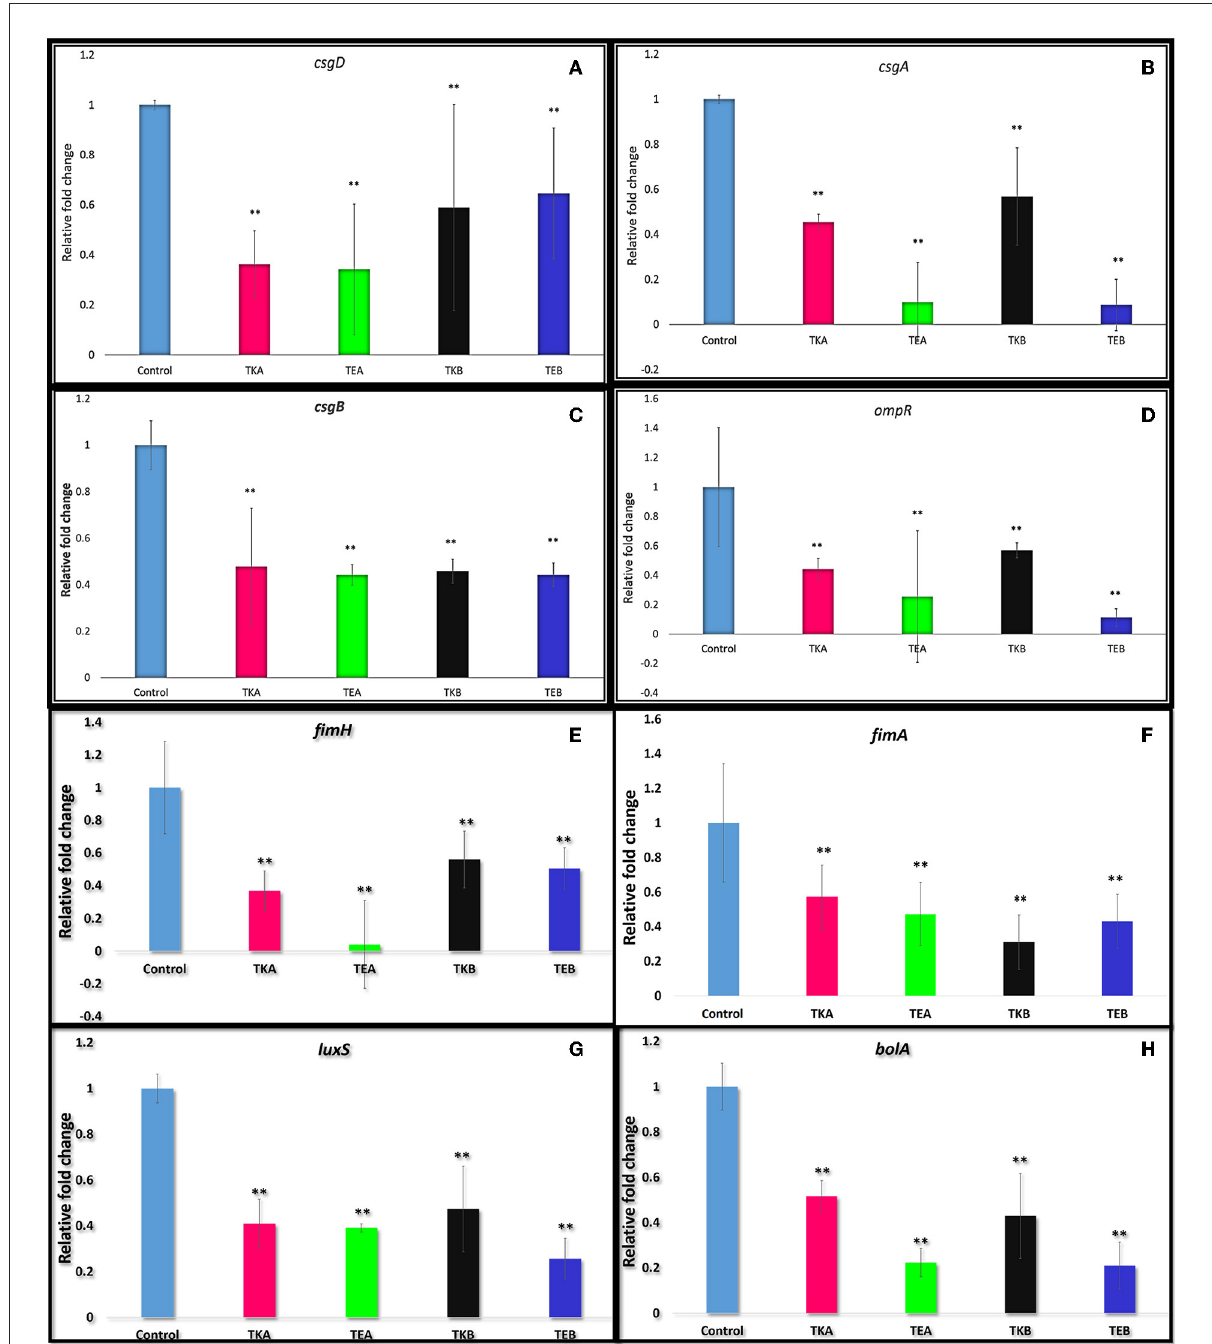
FIGURE1 ( A) csgD gene downregulation quantified by quantitative real-time PCR in E. coli Nissle 1917 (EcN) and K12 strain. The csgD -KD mutant A showed a 65.8% suppression in EcN (TEA) and in K12 cells and 63.8% reduction (TKA) as compared to the control cells (cells having no aTc induction but have both plasmids). The csgD -KD mutant B showed a 35.4% reduction in EcN (TEB) and 41.0% reduction in K12 (TKB). (B–H) Downregulation of the different genes in csgD -KD cells of EcN (TEA and TEB) and K12 (TKA and TKB). (B) Downregulation of csgA gene. (C) Downregulation of csgB gene. (D) Downregulation of ompR gene. (E) Downregulation of fimH gene. (F) Downregulation of fimA gene. (G) Downregulation of luxS gene. (H) Downregulation of bolA gene. The gene expression data was represented in fold change. One-way ANOVA analysis was done, and the * p -value < 0.05, ** p -value < 0.005 was considered statistically significant. The 16s rRNA gene was used as endogenous